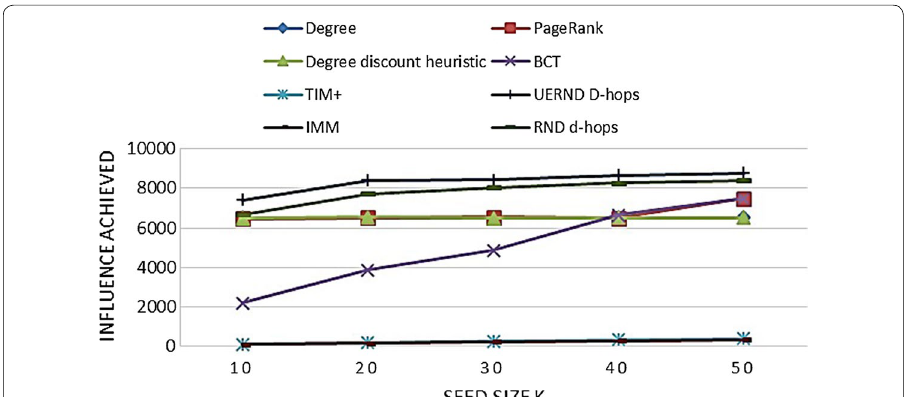
Fig. 2 Influence coverage of our algorithm UERND D-hops compared with state of the art algorithms under the IC model on Nethept data. Degree PageRank Degree discount heuristic BCT TIM RND